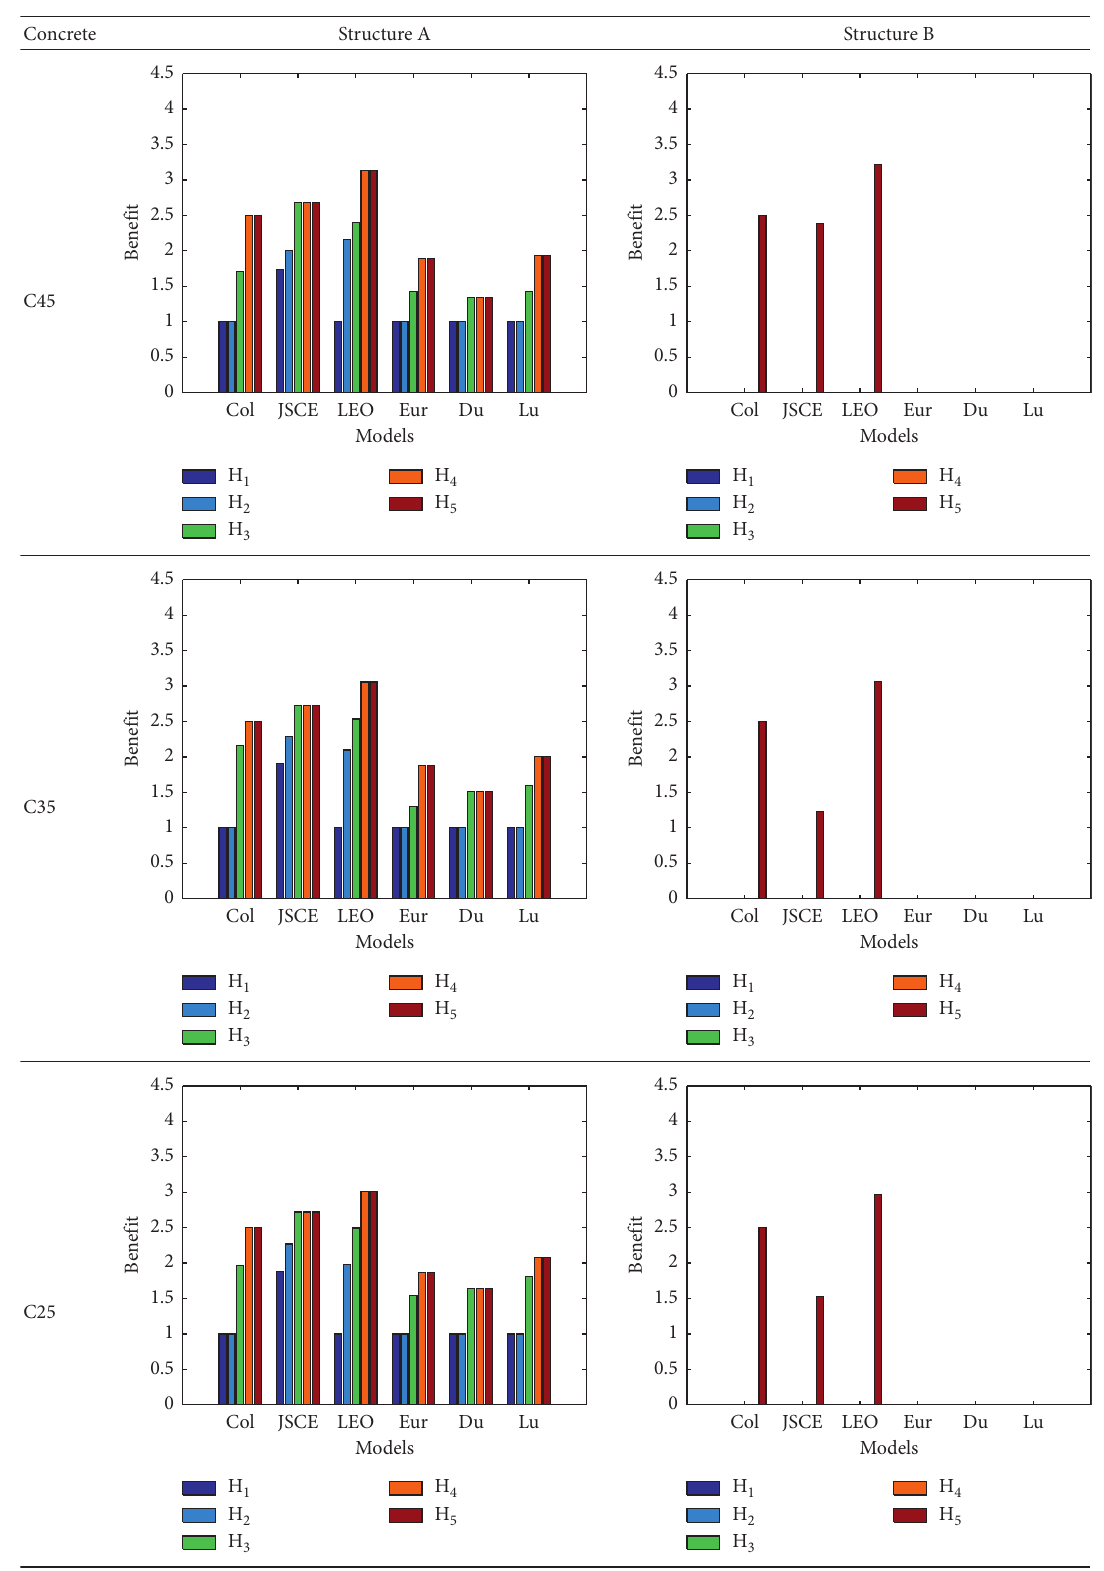
Figure 4: Benefit of each chloride ingress model according to each hypothesis for structure A and structure